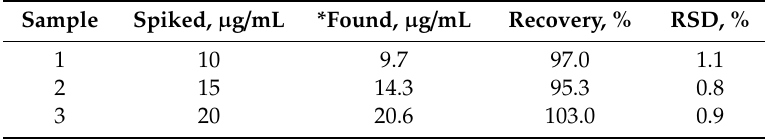
Table 4. Cytarabine assessment in human serum using the proposed